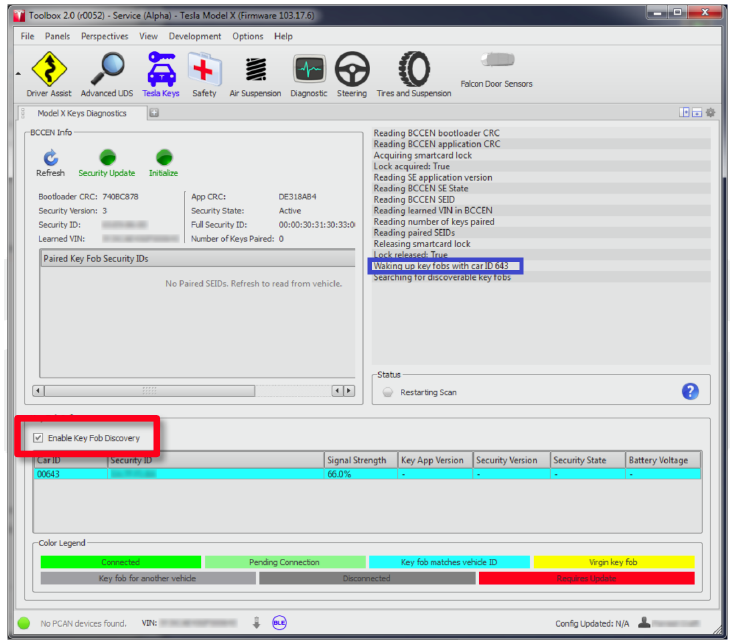
Figure 3: A screenshot of the Tesla Toolbox software. Note that this screenshot indicates that the tool can be used to wake up key fobs (blue rectangle) and that the tool can discover key fobs that are advertising (red rectangle). Picture source: https://static . nhtsa . gov/ odi/tsbs/2016/SB-10081823-5448 .